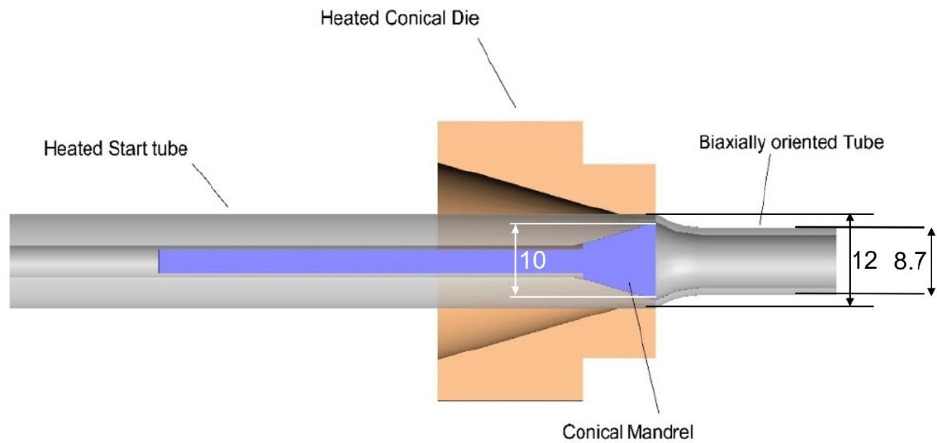
Figure 2. Die arrangement for tube manufacture. Dimensions in mm.